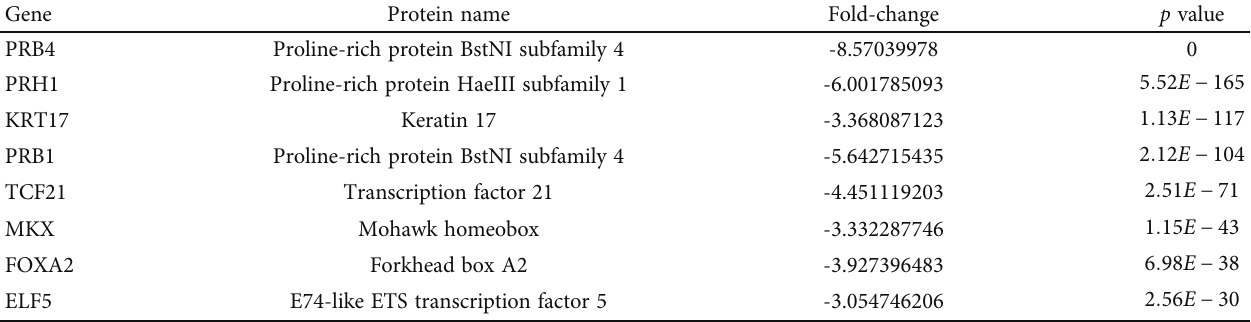
Table 5: Top eight downregulated transcription factors in skin cutaneous melanoma patients with high SAMMSON expression.